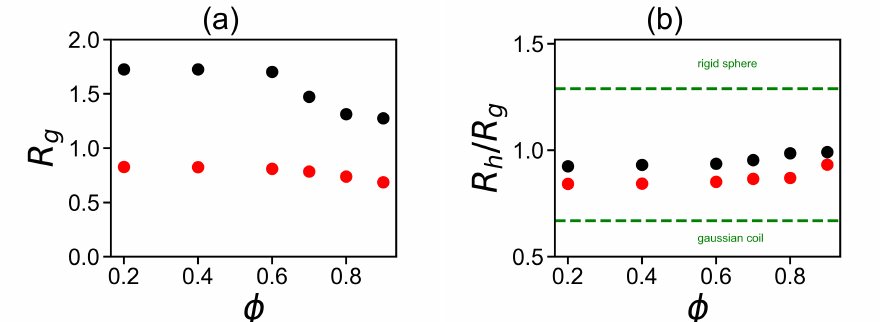
Figure 3. ( a ) The mean-squared radius of gyration R g for DGL1 (red points) and DGL2 (black points); and ( b ) the characteristic ratio of the hydrodynamic radius R h in the Kirkwood approximation to the gyration radius R h / R g for DGL1 (red) and DGL2 (black) as the function of the volume fraction φ . Two theoretical limits (the Gaussian coil and the rigid sphere) are depicted in the figure by the dashed lines.